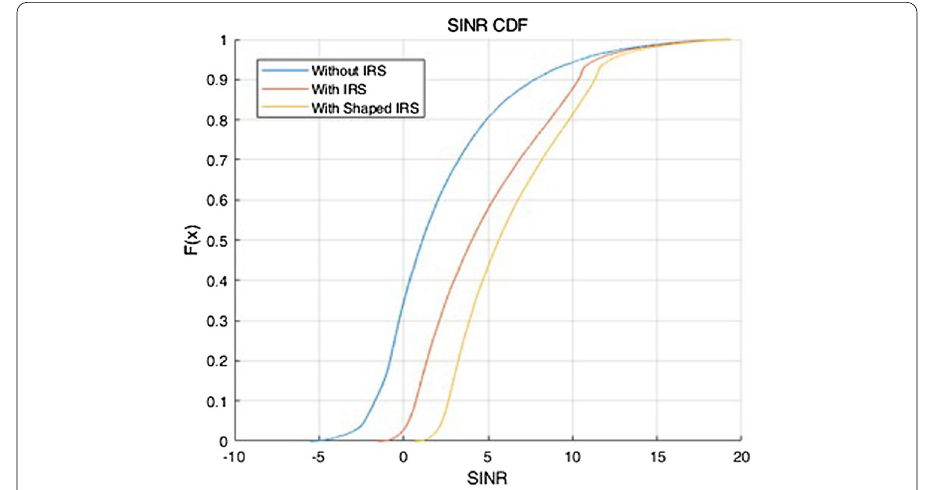
Fig. 6 Simulation results. The three CDF curves represent the three situations where IRS is not deployed, IRS is deployed, and shaped IRS is deployed